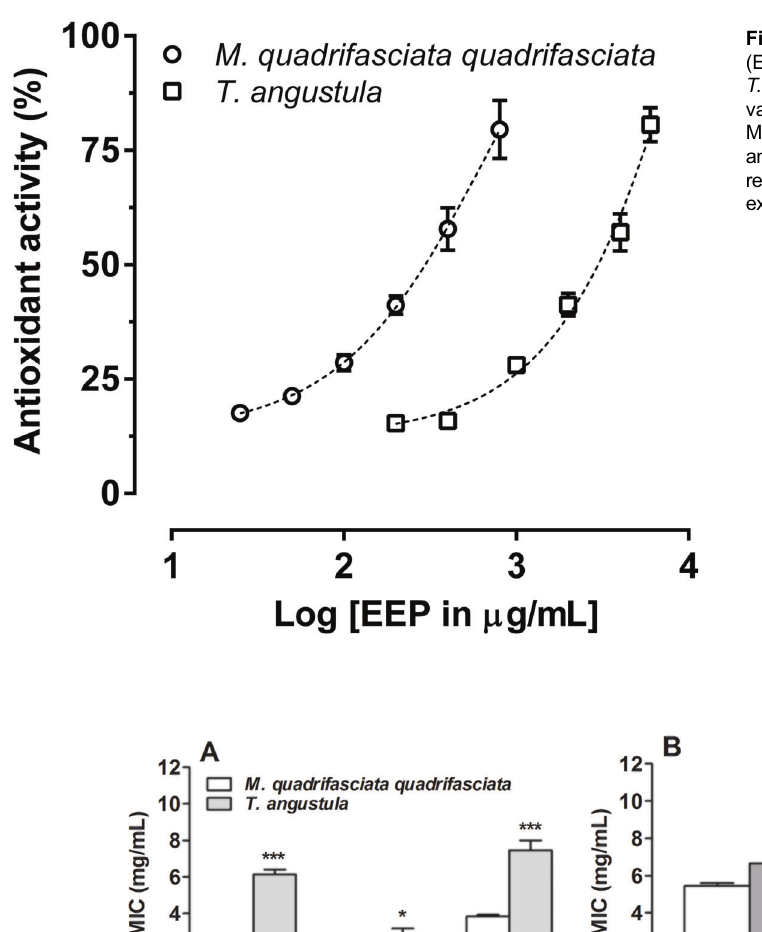
Figure 2. Effect of ethanolic extracts of propolis (EEP) from M. quadrifasciata quadrifasciata and T. angustula on DPPH radical scavenging. IC 50 values were obtained by nonlinear regression; M. quadrifasciata quadrifasciata : IC 50 =241.8 m g/mL and T. angustula : IC 50 =2433.0 m g/mL. Data are reported as means ± SE of three independent experiments performed in triplicate.